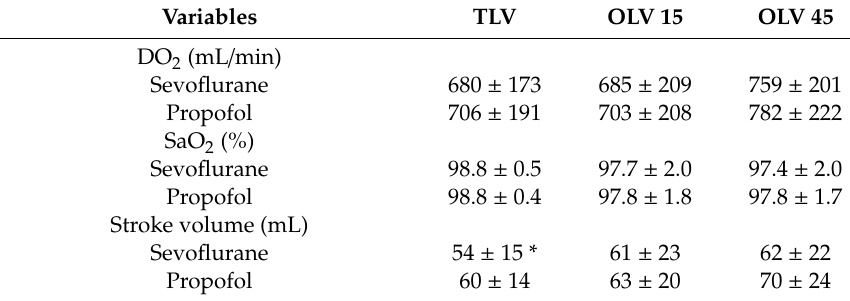
Table 2. Major haemodynamic